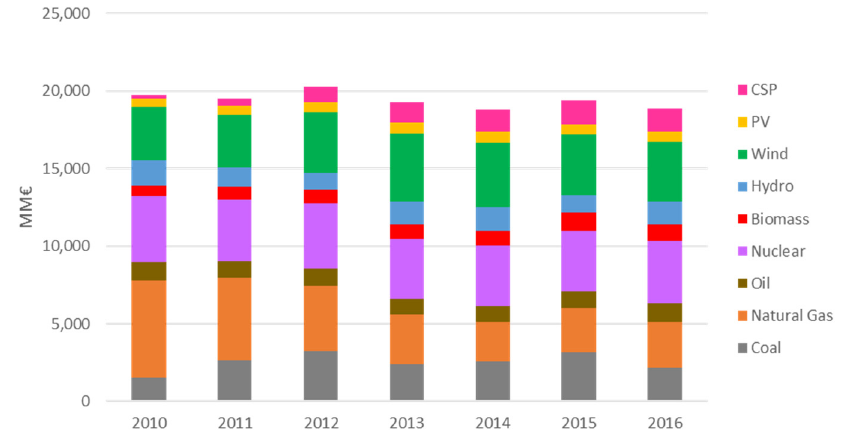
Figure 10. Historic values of power generation costs estimated as a summation of LCOE of all contributing technologies.